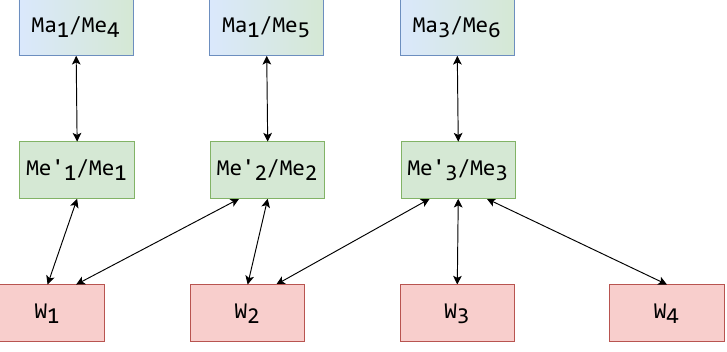
Figure 13. Architecture used in the